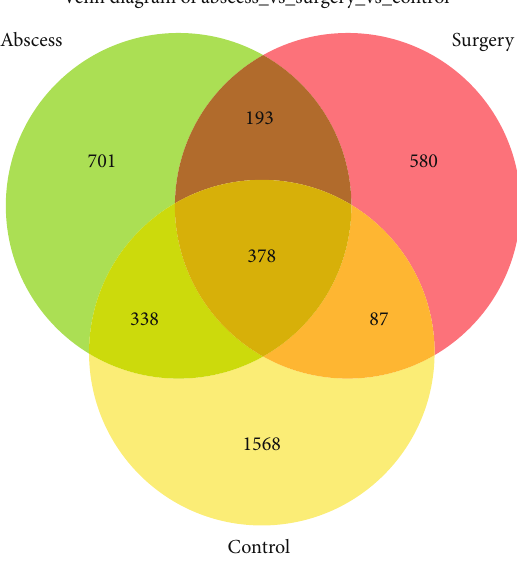
Figure 2: Venn diagram of the composition of ASVs in gut